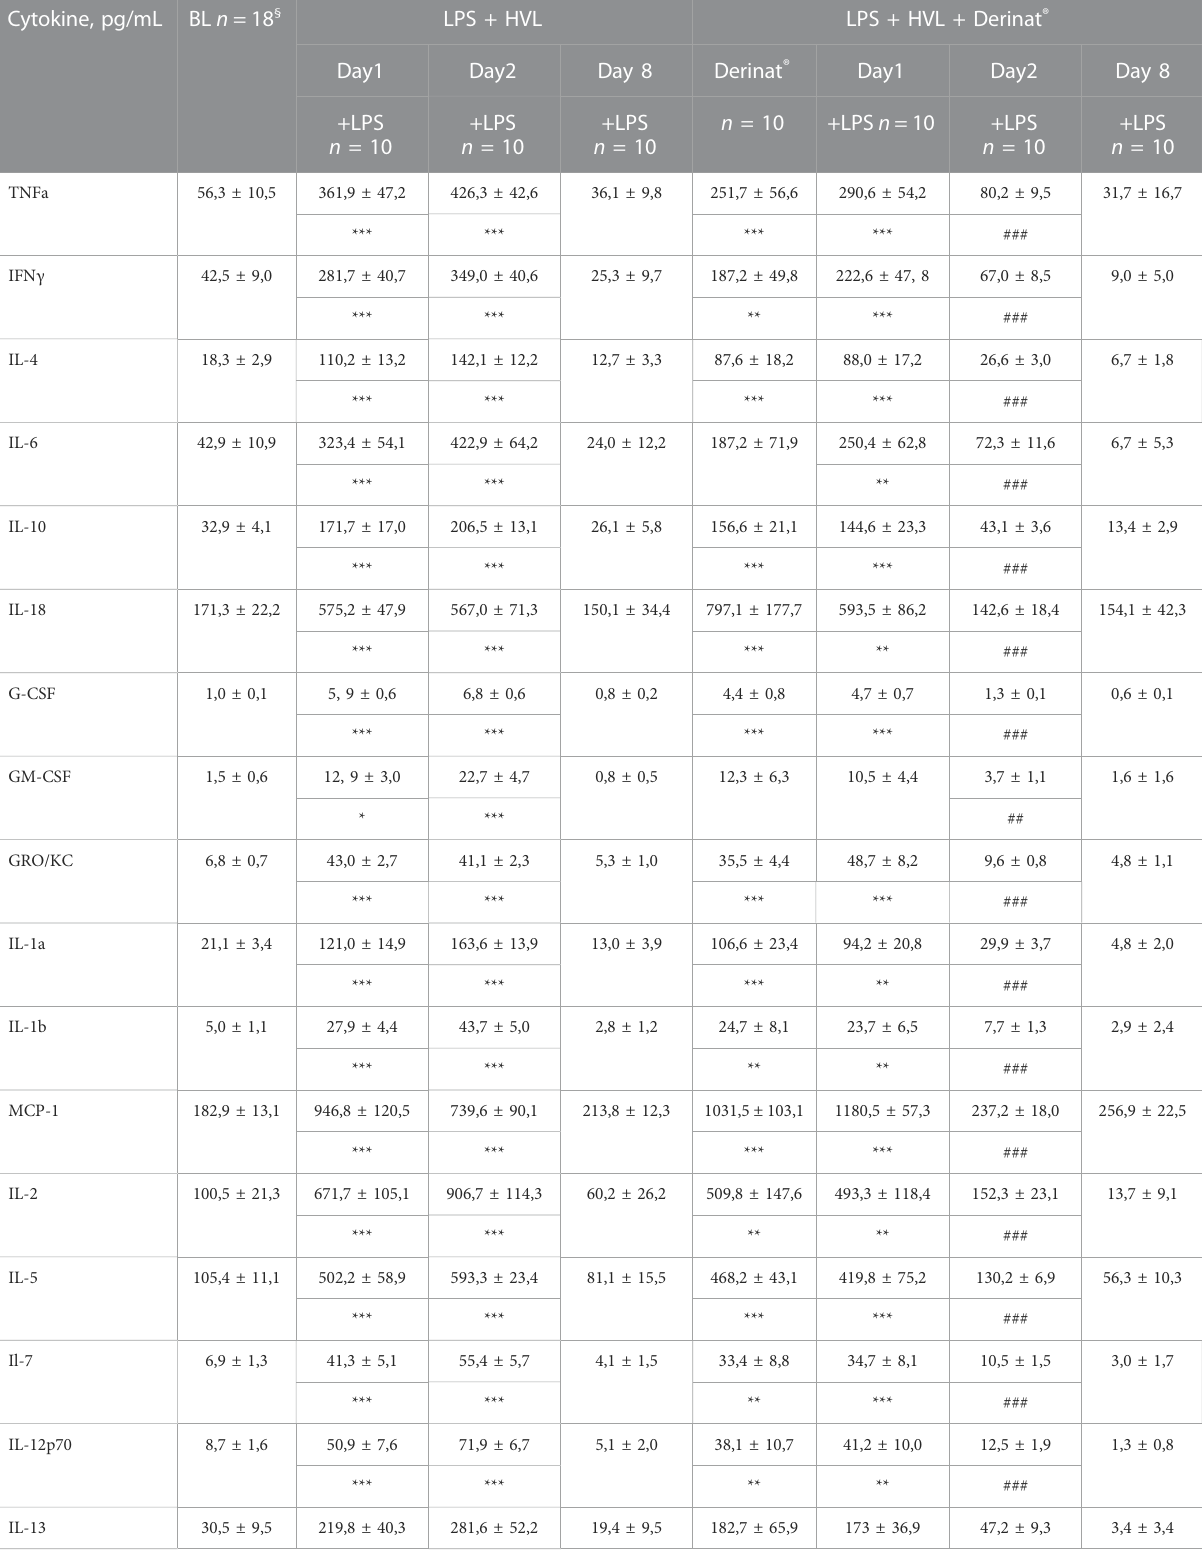
TABLE 1 The concentration of cytokines in the blood of SD rats in dynamics before and after ALI simulation. Cytokine, pg/mL